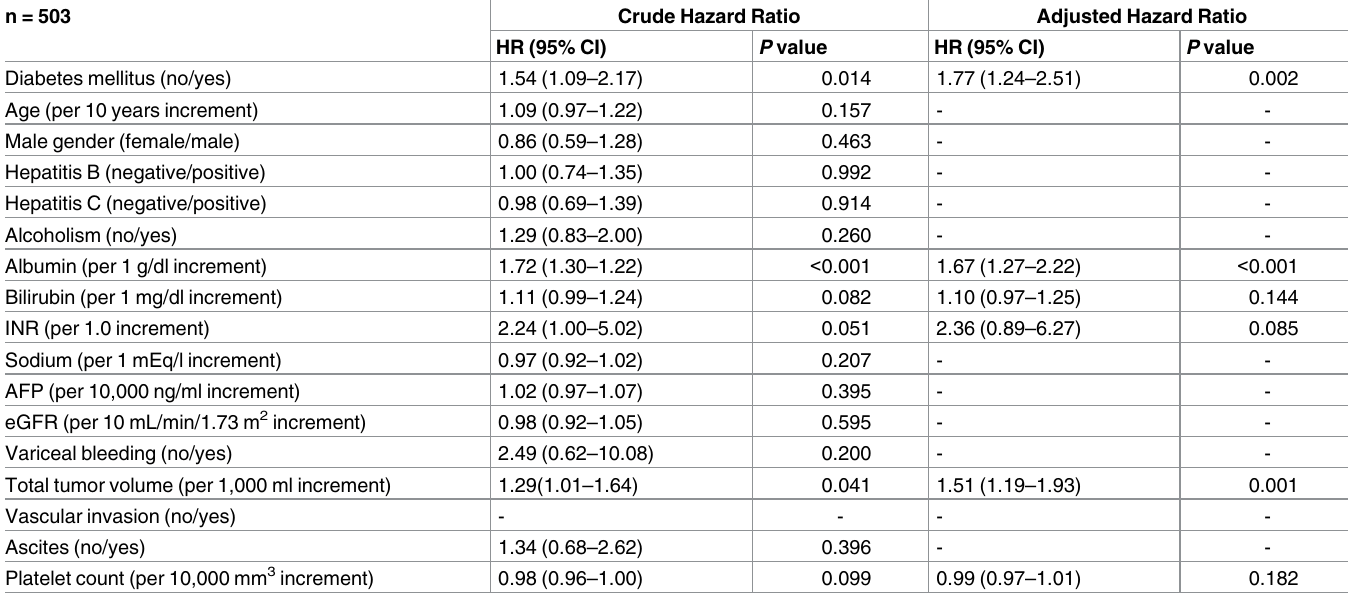
Table 4. Univariate and multivariate Cox survival analysis in patients with BCLC stage B hepatocellular